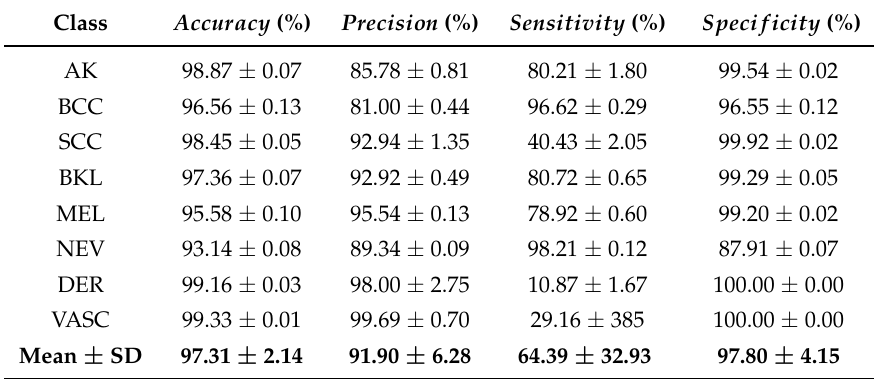
Table 6. Mean ± SD of five performance metrics for the training dataset of the Exp-3 with α = 0.4. The training dataset has